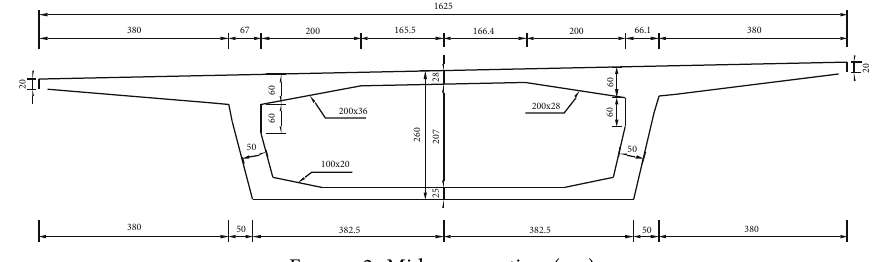
Figure 2: Mid-span section (cm).